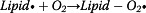
The proposal reaction of phenolic acids binding Fe2+.